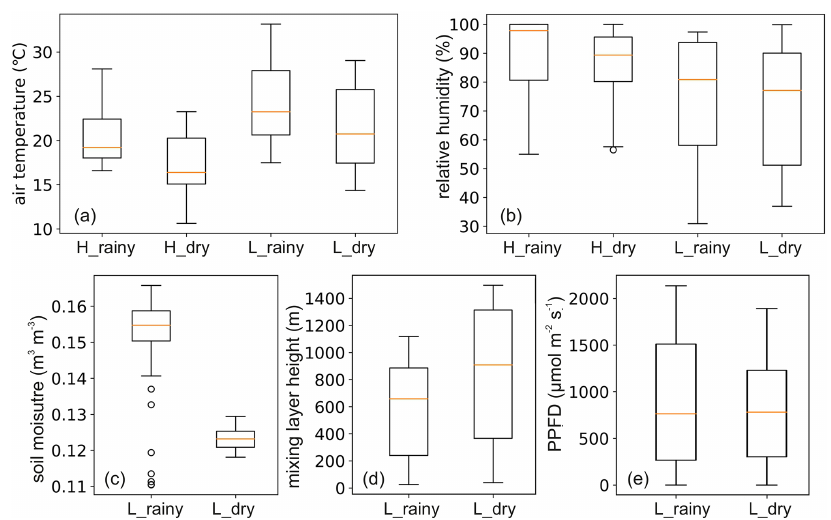
Figure 3. Meteorological measurements in the highland (H) and lowland (L) ecosystems during the rainy and dry seasons. PPFD is photo- synthetic photon flux